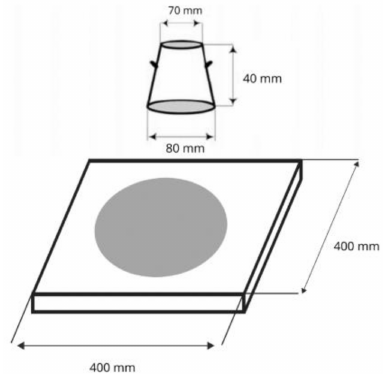
Figure 3. Slump flow